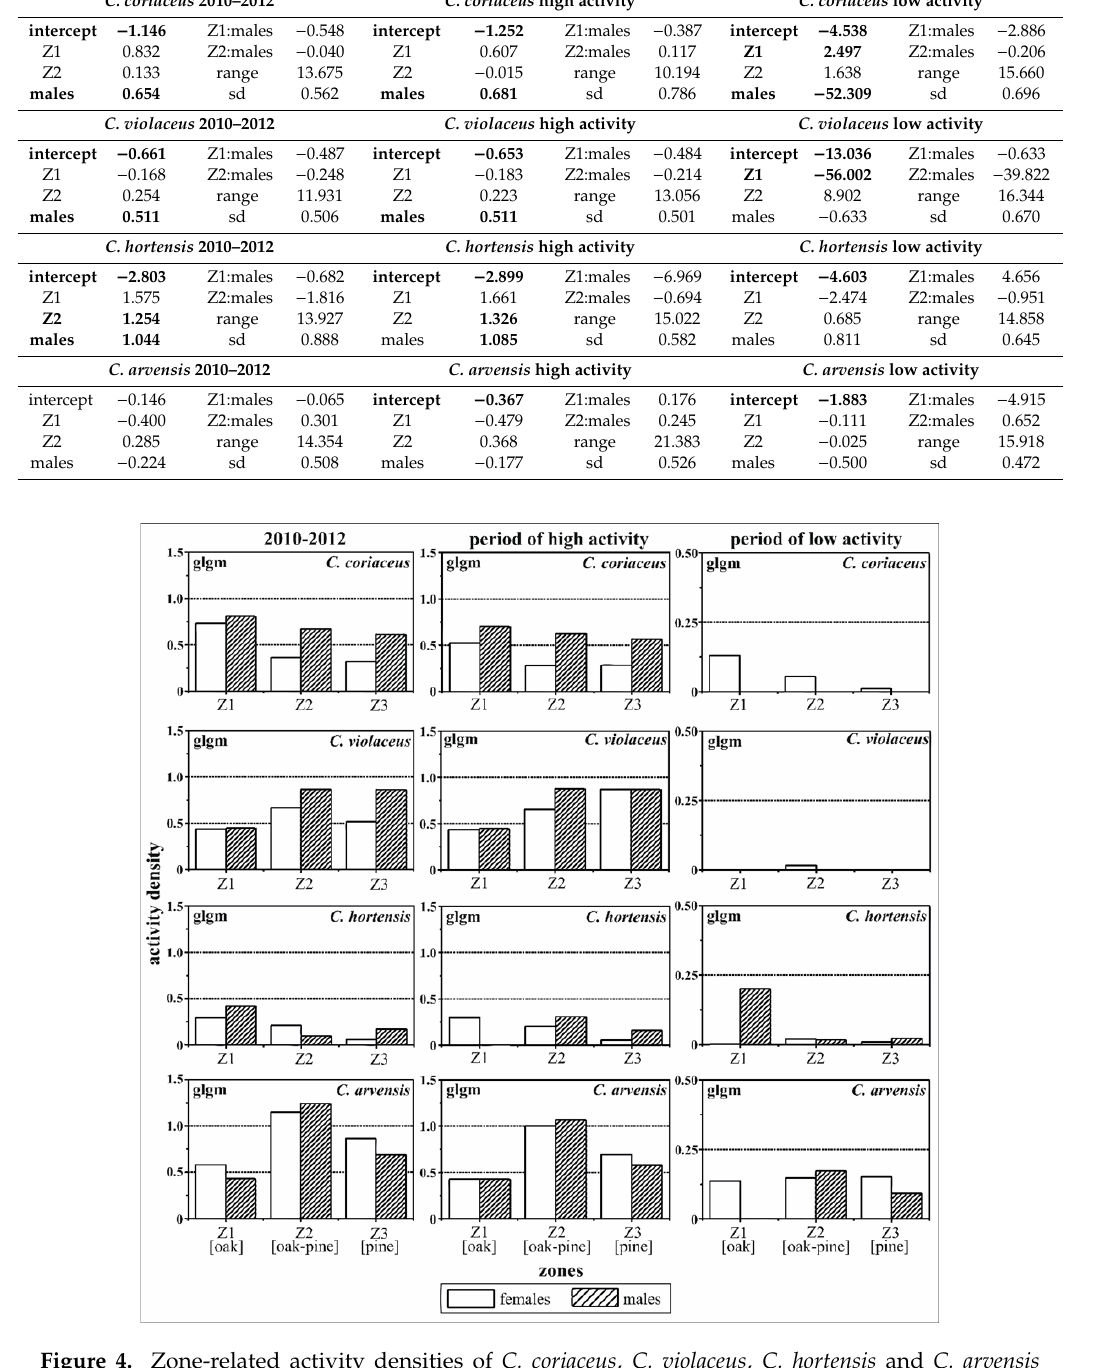
Figure 4. Zone-related activity densities of C. coriaceus , C. violaceus , C. hortensis and C. arvensis di ff erentiated by sex (females versus males). Females and the pine zone were used as the reference for the model calculation. The results of the generalised linear geostatistical model (glgm) address e ff ects of zoning and sex simultaneously for di ff erent activity periods (high activity period: May to September, low activity period: October to April); Z1—oak zone, Z2—oak–pine zone, Z3—pine